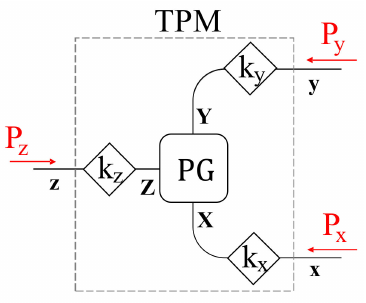
Figure A1. Scheme of a three-port mechanism with one PG (illustrated by a rounded-corner square) and three OGs (rhombi) realizing the k j fixed-ratio. Red arrows indicate the positive direction of power